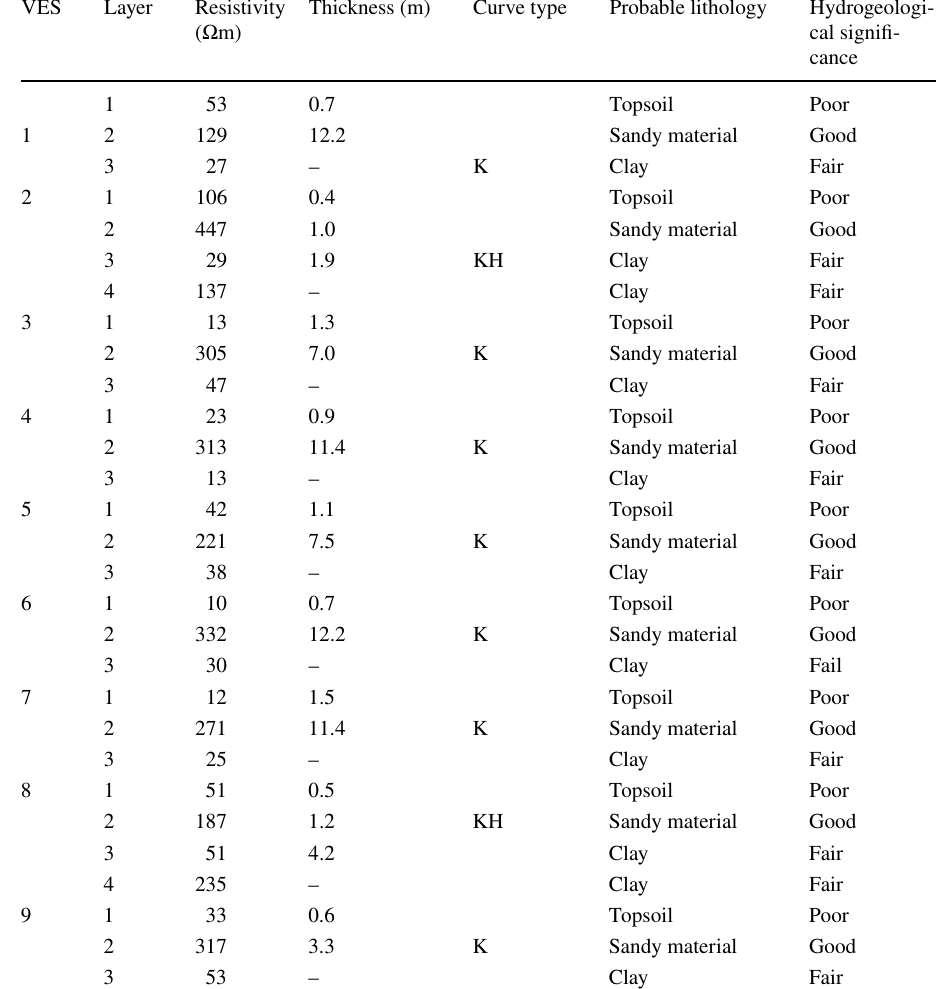
Table 1 Summary of the VES